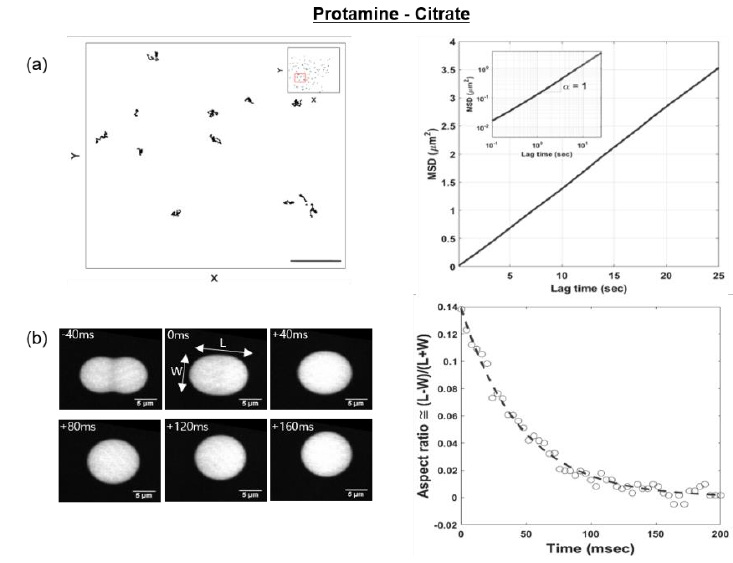
Figure 6. Measurements of viscosity and interfacial tension of the protamine / citrate complex coacervate. ( a ) Left: Tracked movements ( n = 189) of fluorescent probe particles dispersed in the dense phase of the complex coacervate. Scale bar: 5 µ m. Right: The averaged mean square displacement (MSD)–lag time plot of particles (0.2 µ m) in the dense phase. Inset is a log–log plot. ( b ) Left: Confocal image of the coalescence of droplets. Right: Aspect ratio–time plot. The aspect ratio is defined as ( L − W ) / ( L + W ), where L and W are the length and width, respectively, of the deformed droplet under relaxation. All experiments were performed at 20 °C.